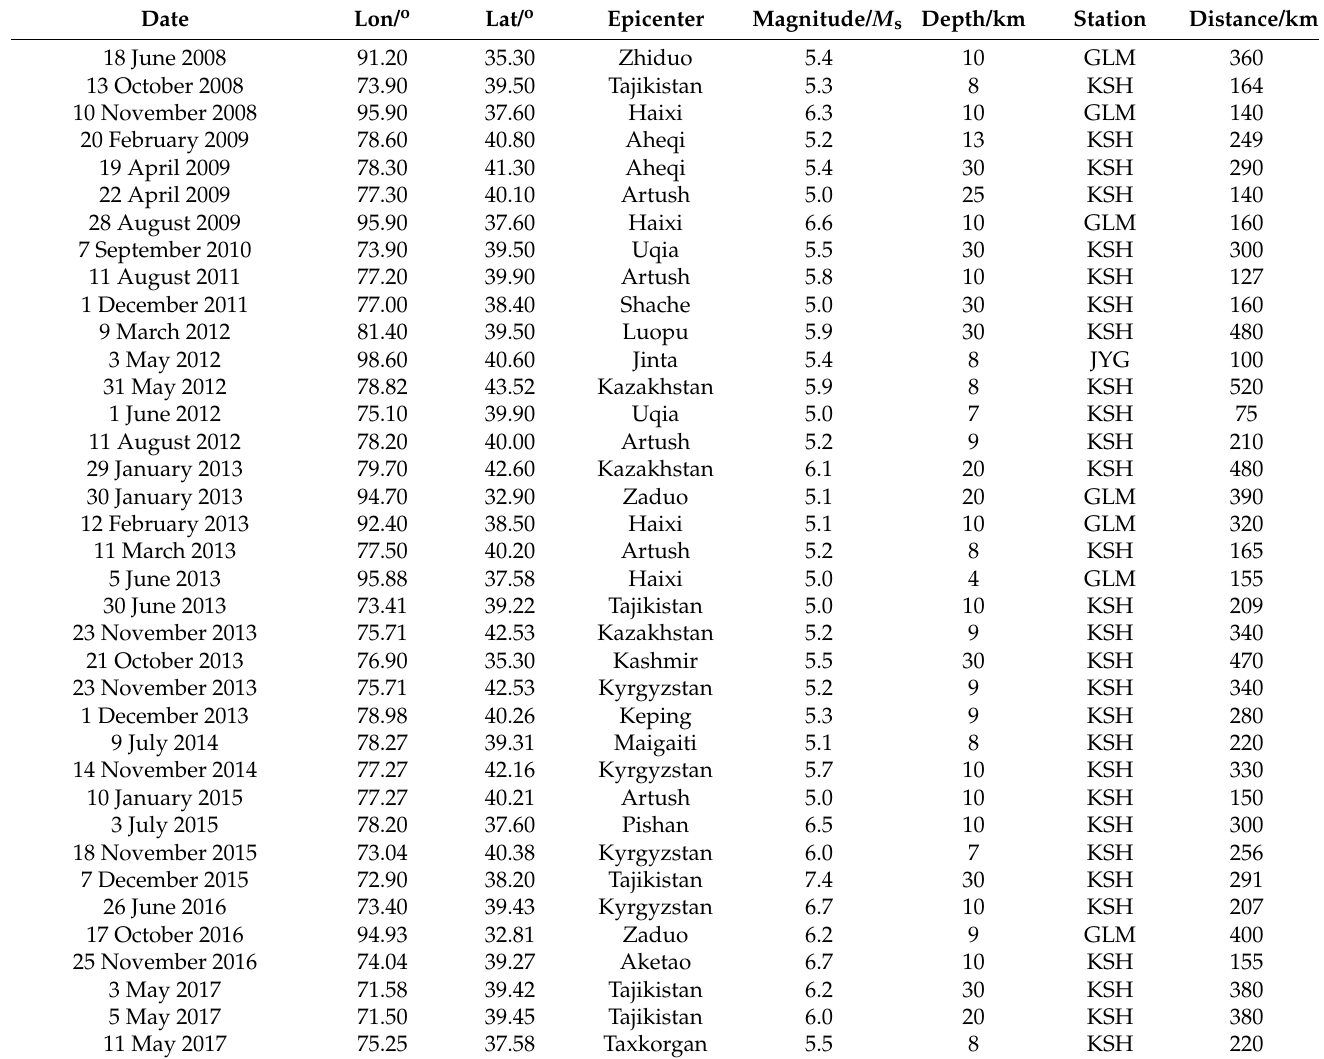
Table 1. Information of earthquakes and